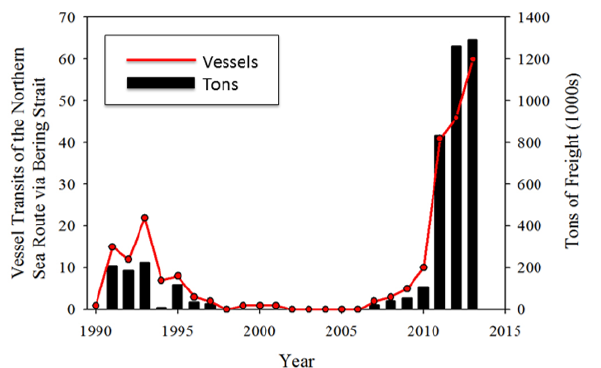
Fig. 1 . Reported vessel traffic on the Northern Sea Route,